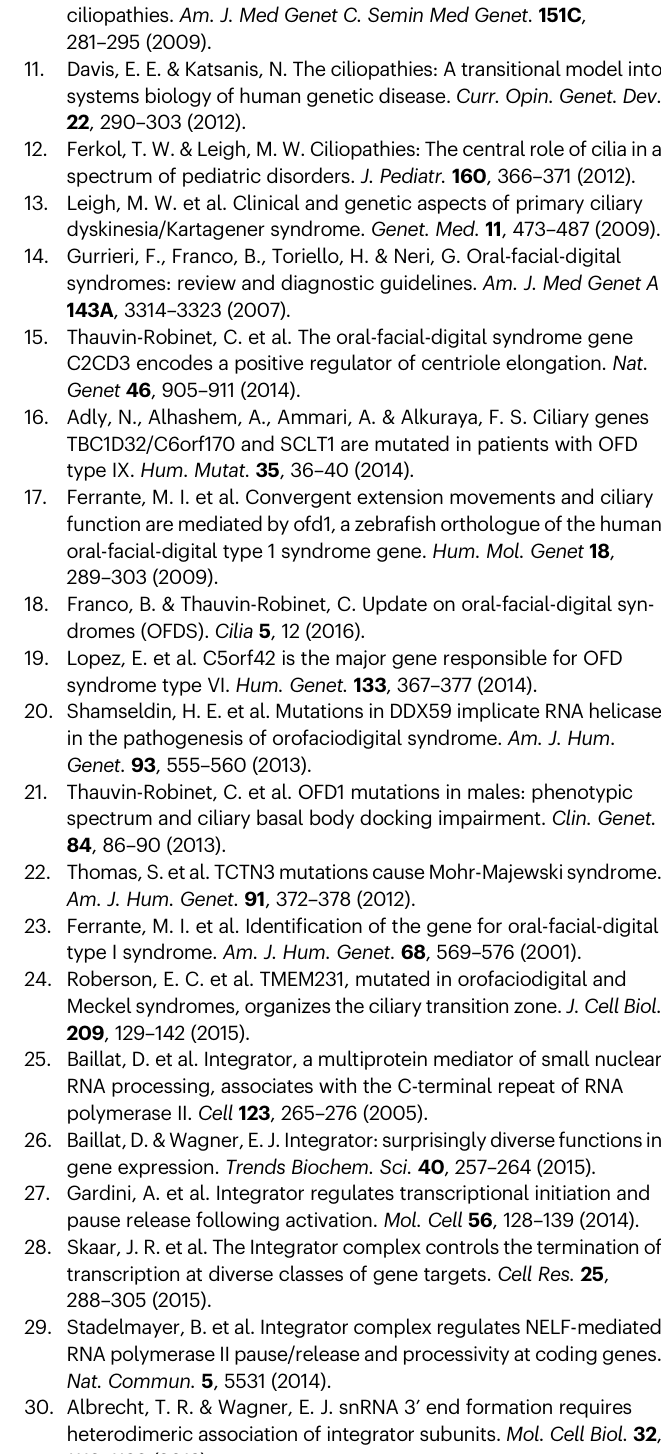
Figure 5a: siRNA treatment of RPE cells to knock down INTS13 was done multiple times for various experiments. This blot is a repre- sentative image of those results. We saw slight variations in the level of proteinknockdownbetweenexperimentsbutreducedexpressionwas always seen.